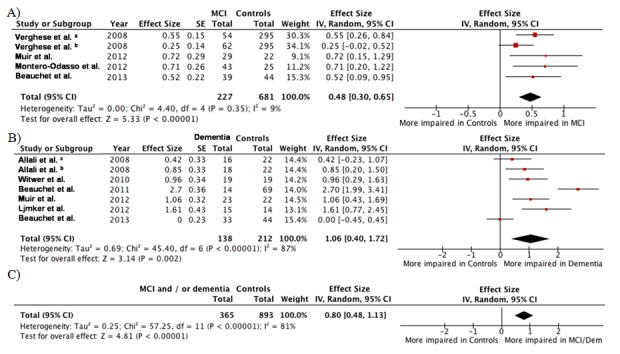
Meta-analyses of studies examining the associations between stride time variability and decline in cognitive performance.Forest plots for effect size of high stride time variability A) in cognitively healthy individual and patients with mild cognitive impairment, B) in cognitively healthy individual and demented patients, C) in cognitively healthy individual and patients with decline in cognitive performance (i.e., mild cognitive impairment or dementia). The square area is proportional to the sample size of each study, and horizontal lines correspond to the 95% confidence interval. The diamond represents the summary value. The vertical line corresponds to 0.0, equivalent to no difference. a: Patients with amnestic Mild Cognitive Impairment. b: Patients with non-amnestic Mild Cognitive Impairment. c: Demented patients with executive dysfunction. d: Demented patients without executive dysfunction.